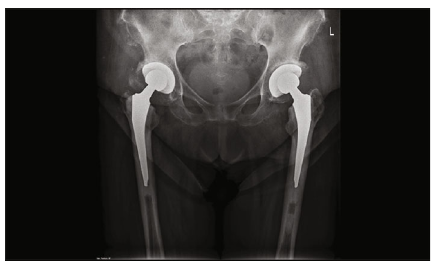
Figure 3: 8 weeks of follow-up anteroposterior X-ray of the